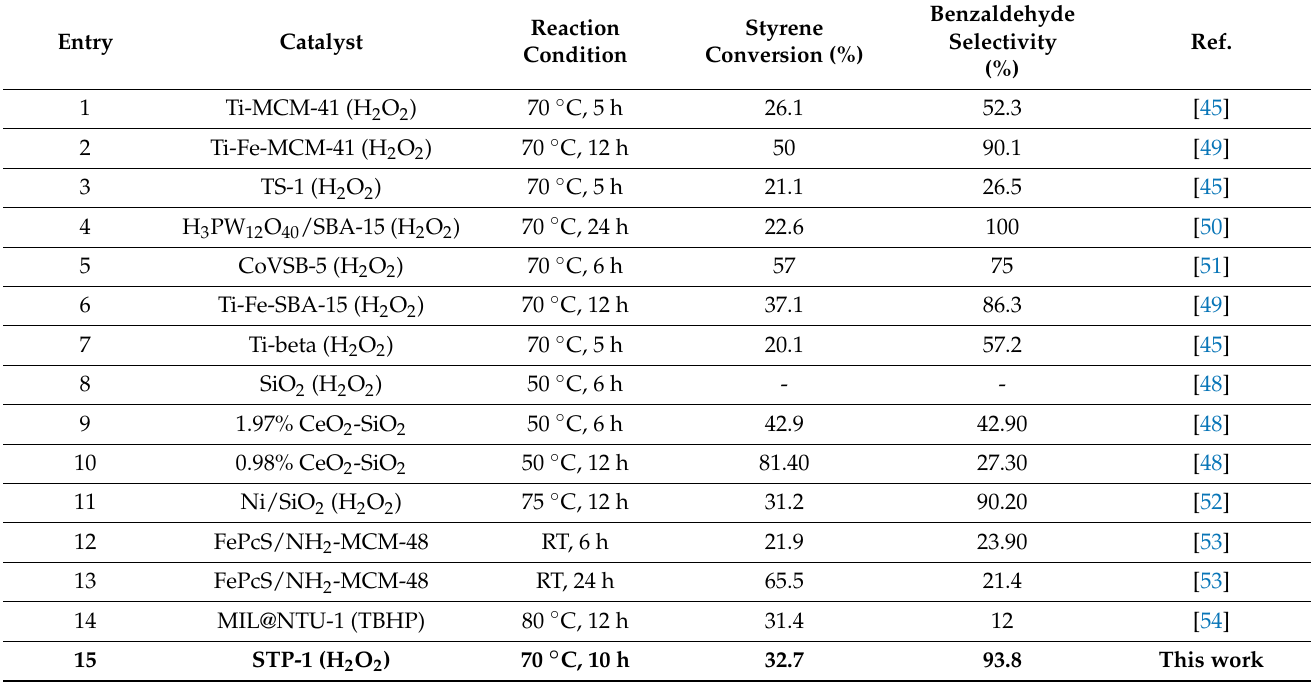
Table 2. Comparison study with the previously reported state-of-the-art